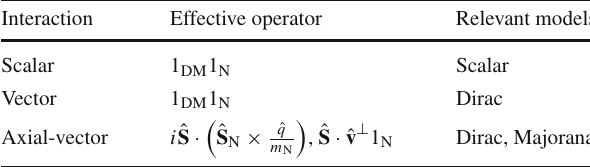
Table 2 Effective Operator matching to each model Interaction Effective operator Relevant